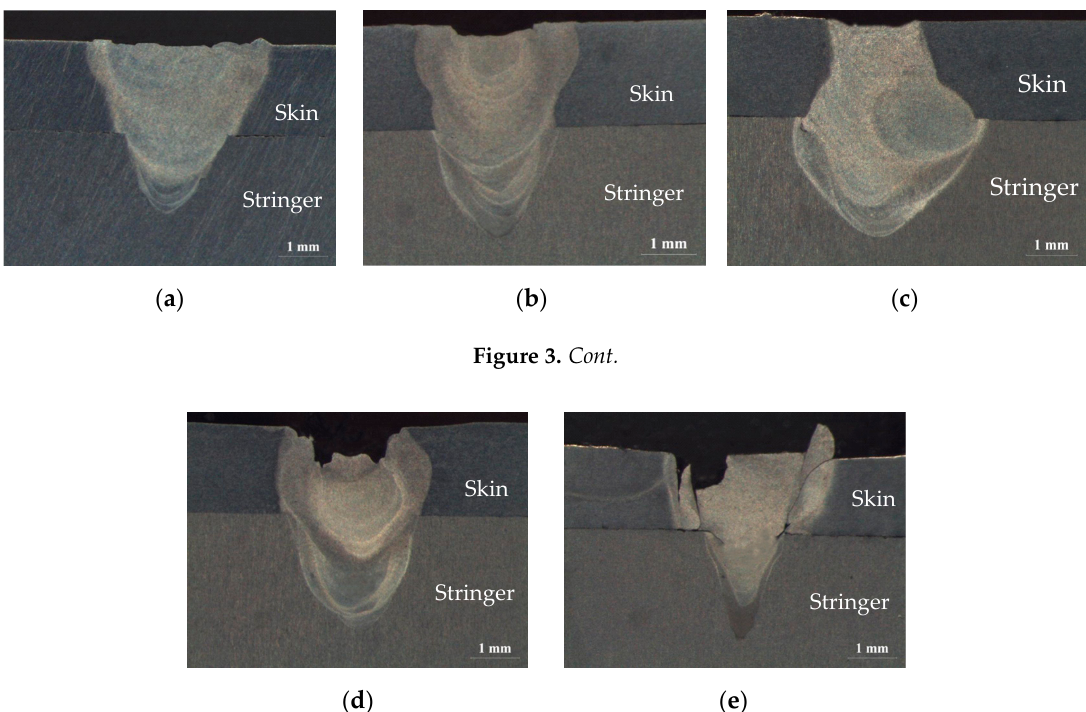
Figure 3. Typical macrographs of the weld morphology produced with different aided electric currents (fixed process parameters: laser power, P = 1.6 kW; welding speed, v = 0.72 m/min; pressing force, F = 1.1 kN): ( a ) 0 kA; ( b ) 3.5 kA; ( c ) 5.0 kA; ( d ) 6.0 kA; ( e ) 7.0 kA.